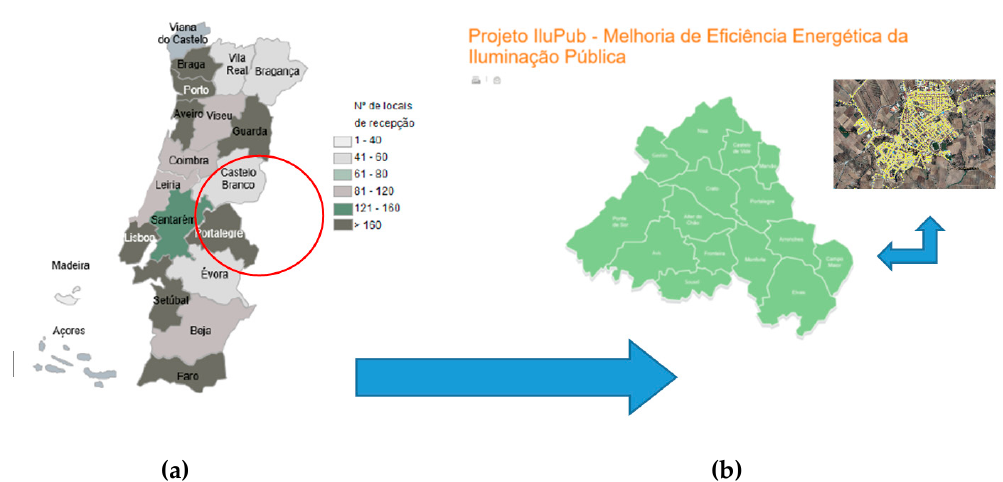
Figure 1. ( a ) Geographical distribution of waste electrical and electronic material (WEEE) collection areas based on local collection companies. ( b ) Study area for collecting the Syntra Luminaire in Alto Alentejo (Portugal) and details of the Campo Maior Zone. (Source: Projeto IlluPub and AMB3e). With the information provided by EDP, it has been possible to count the total number of light points of conventional luminaires (sodium, mercury and metal Halogen discharge lamps (HM) in the Alto Alentejo area (Portugal) (45,160). The results are shown in Table 1. Of the total number of luminaires analyzed, 78% corresponded to the luminaire model, mainly installed, model Syntra, approximately